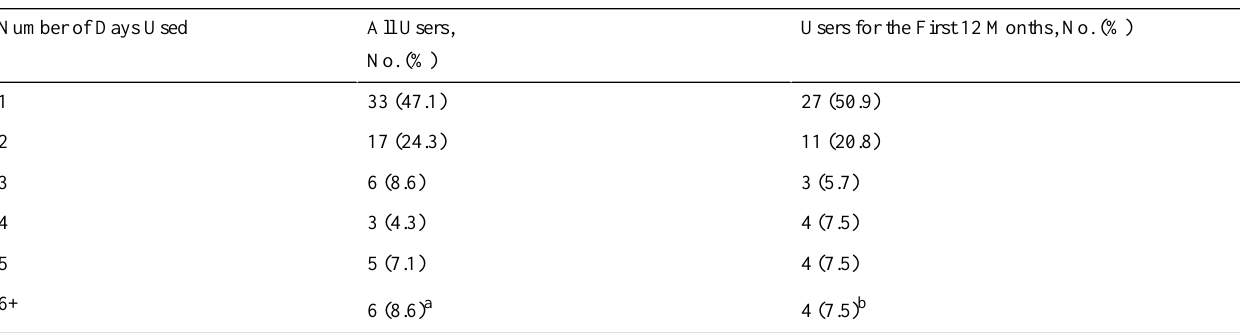
Table 2. Number of discrete days of PHIMS use during the study period for all users (N = 70) and during the first 12 months (N = 53) (%)Number of Days